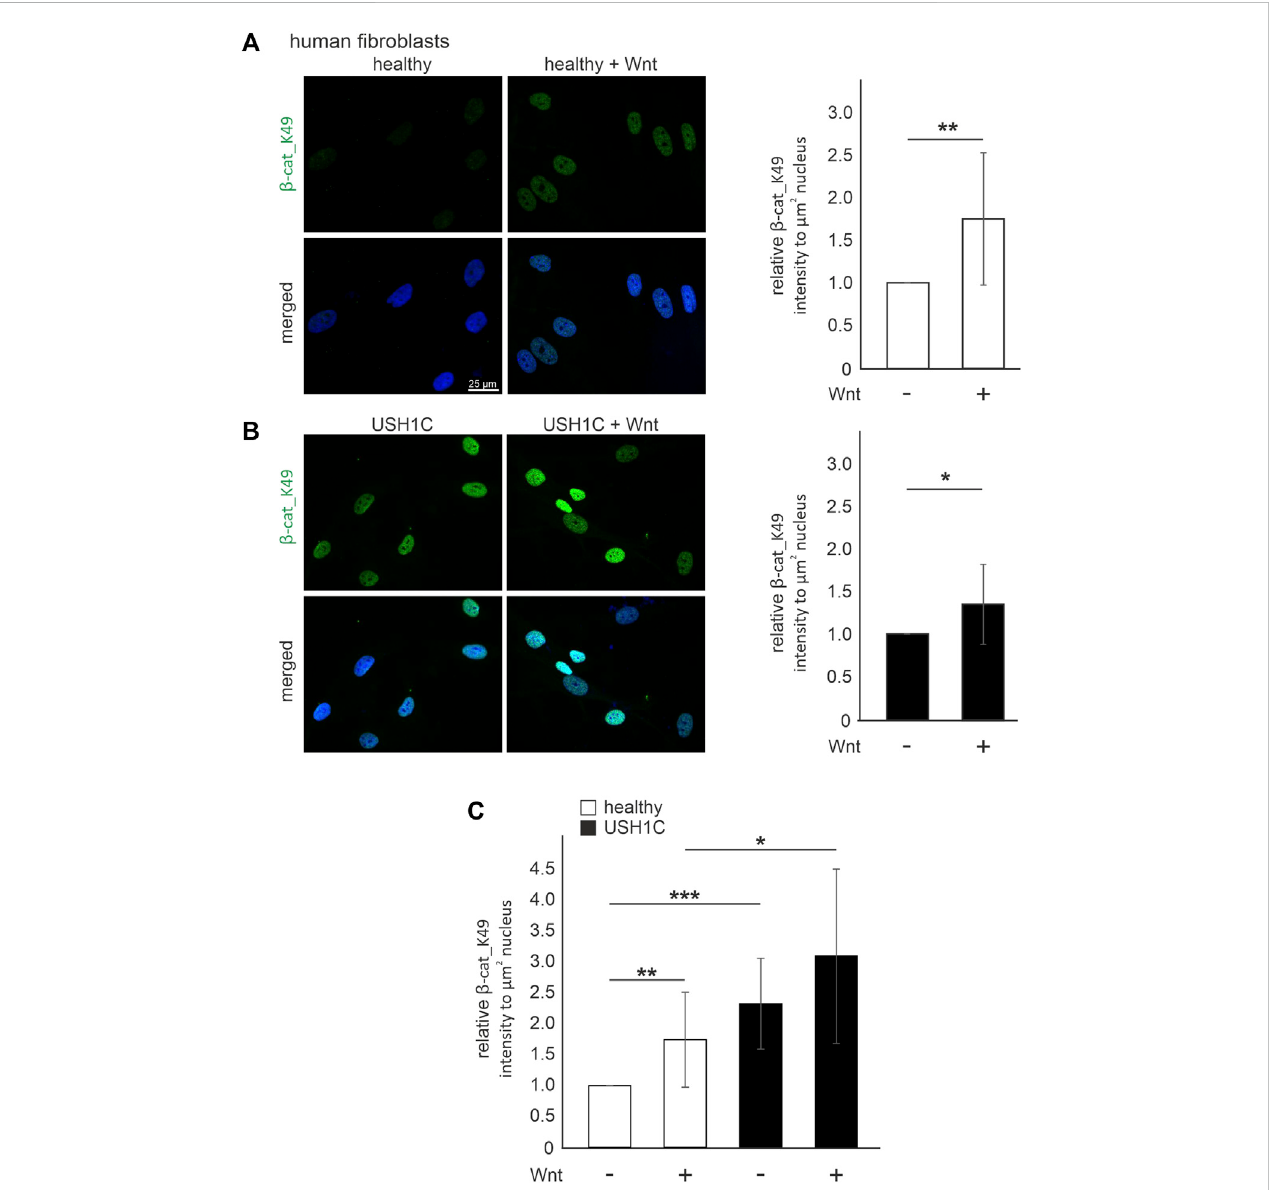
marked with DAPI (blue). Quanti fi cation reveals an increase of β -cat_K49 (1.74-fold) after stimulation with Wnt medium. Two-tailed Student ’ s t -test, ** p ≤ 0.01; N = 12 experiments, cell number: Wnt- n = 1,219; Wnt+ n = 1,276. (B) Immuno fl uorescence analysis shows an increase of β -cat_K49 intensity (green) in Wnt stimulated USH1C R31*/R80Pfs*69 patient derived fi broblasts. The nucleus is marked with DAPI (blue). Quanti fi cation reveals an increase of β -cat_ lys49(1.34-fold)afterstimulationwithWntmedium.Two-tailedStudent ’ s t -test,* p ≤ 0.05;N=12experiments,cellnumber:Wnt-, n =1,282;Wnt+, n